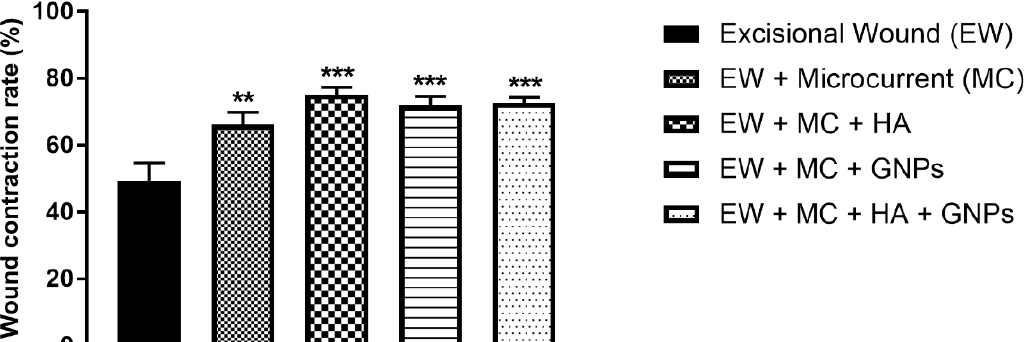
Figure 1. UV – VIS spectroscopy ( A ) and TEM images ( B ) of the GNP solution were obtained.